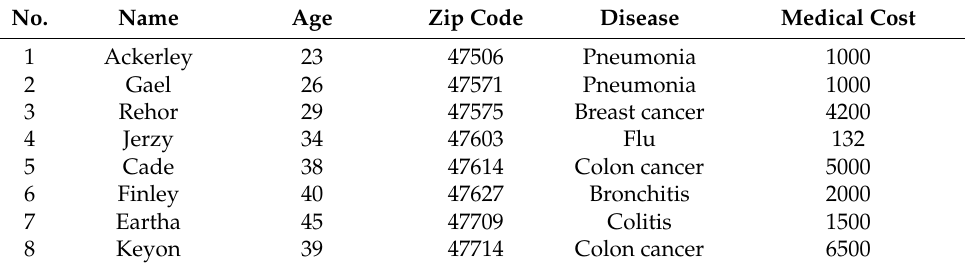
Table 1. Example of personal electronic health record.